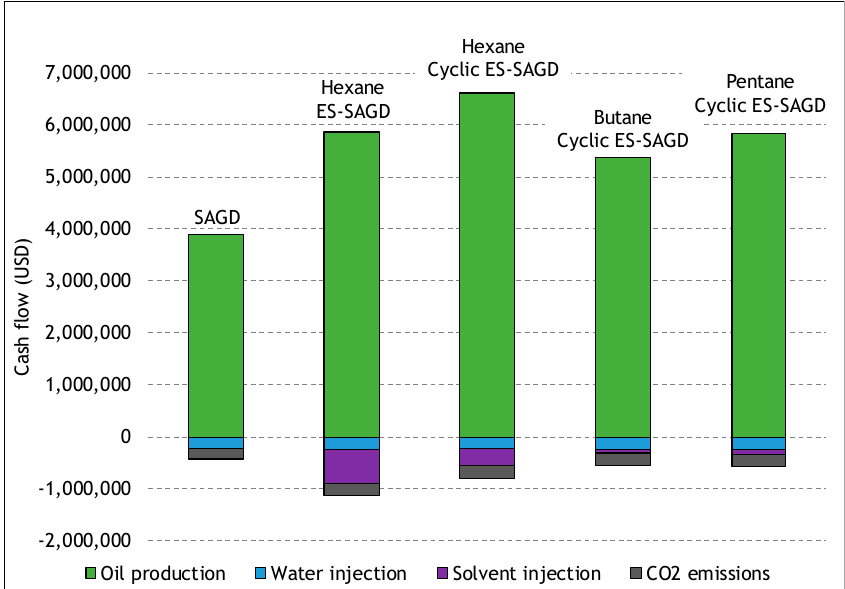
Figure 22. Cash flows after 10 years for each of the cases that were considered for the NPV analysis.